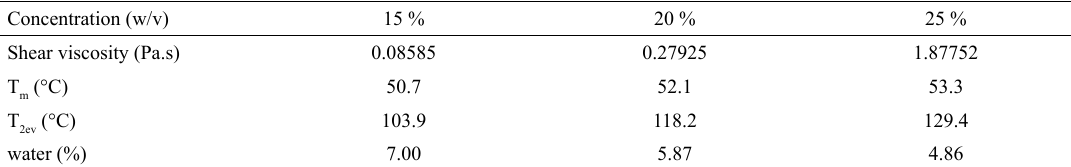
and T obtained from DSC curves; % water obtained from TG thermograms. m 2ev